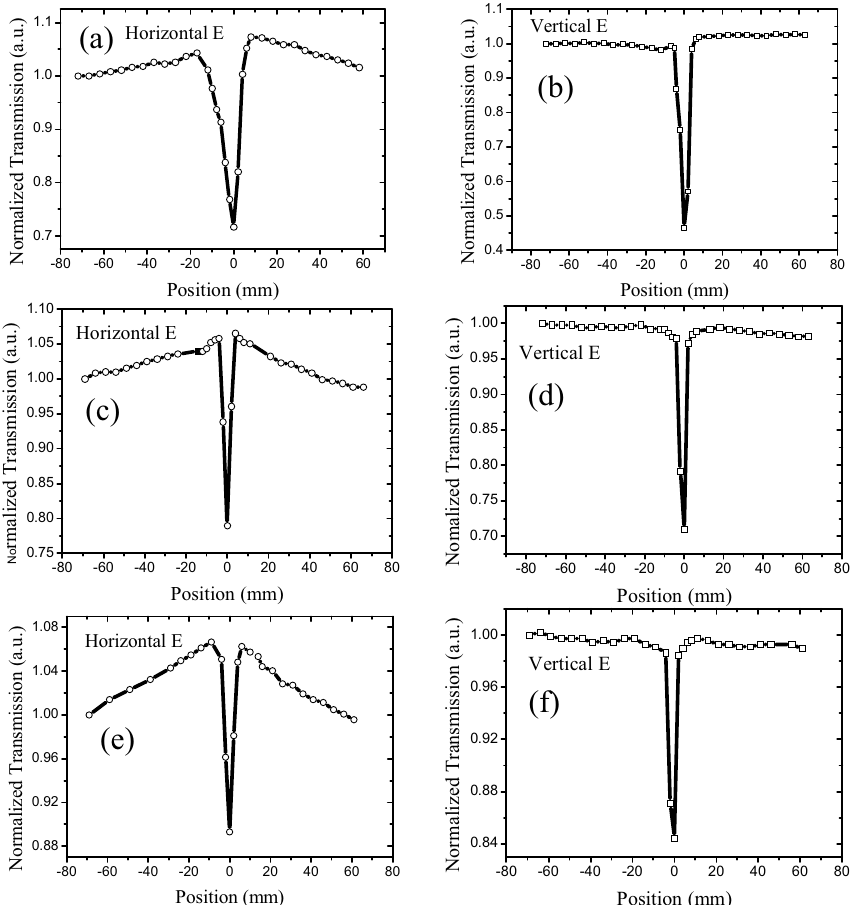
Figure 1. Z-scan results of graphene suspended in NMP: (a,b) 527-nm laser with 100 mW power; transmission of graphene suspension is 10%; cuvette is 10 mm wide; (c,d) 527-nm laser with 50 mW power; transmission of graphene suspension is 10%; cuvette is 5 mm wide; (e,f) 527-nm laser with 50 mW power; transmission of graphene suspension is 60%; cuvette is 10 mm